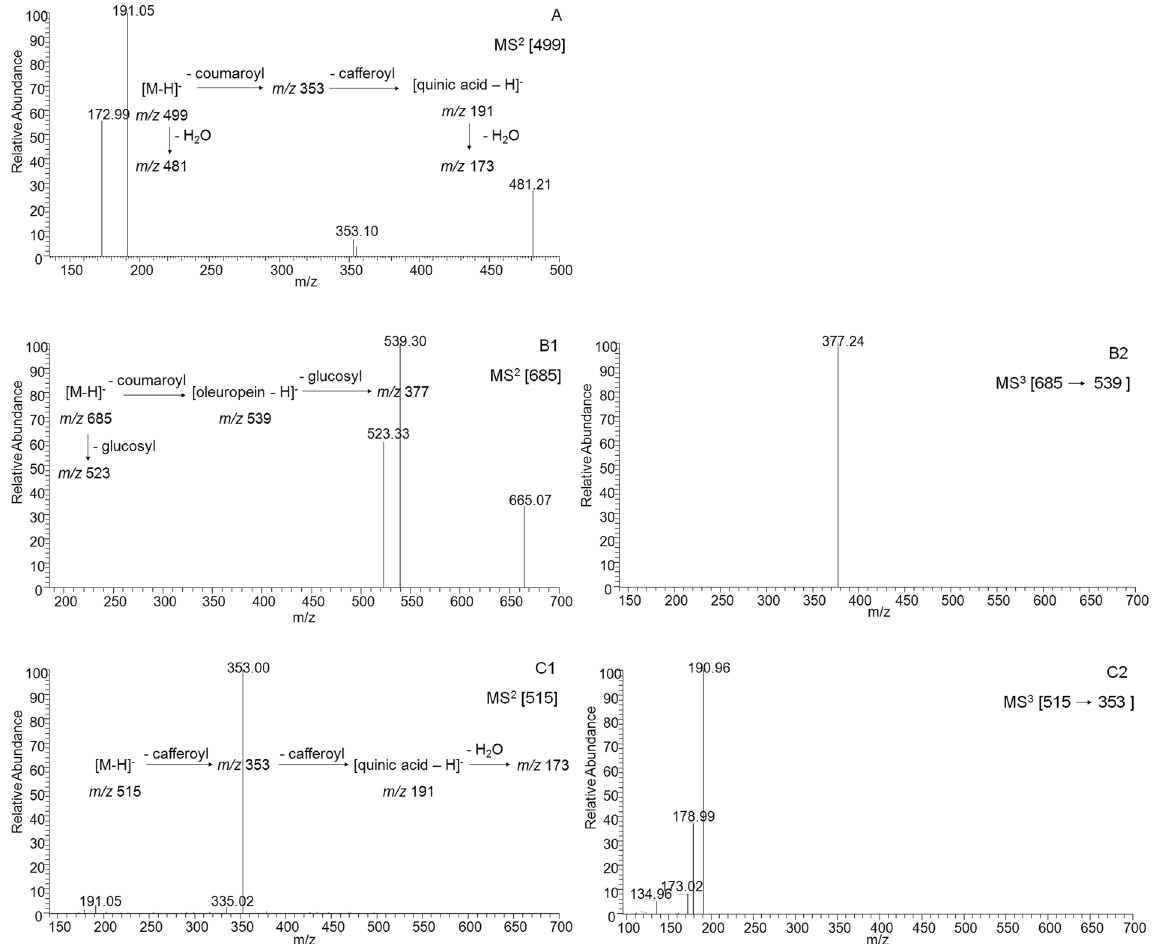
Figure 6. MS n spectra and major fragmentations for the typical hydroxycinnamic acid derivatives in D . indicum var. aromaticum flower. ( A) Compound 1 (3- O -caffeoyl-5- O - p - coumaroylquinic acid); ( B) compound 2 (coumaroyloleuropein); ( C) compound 5 (3,5-dicaffeoylquinic acid).